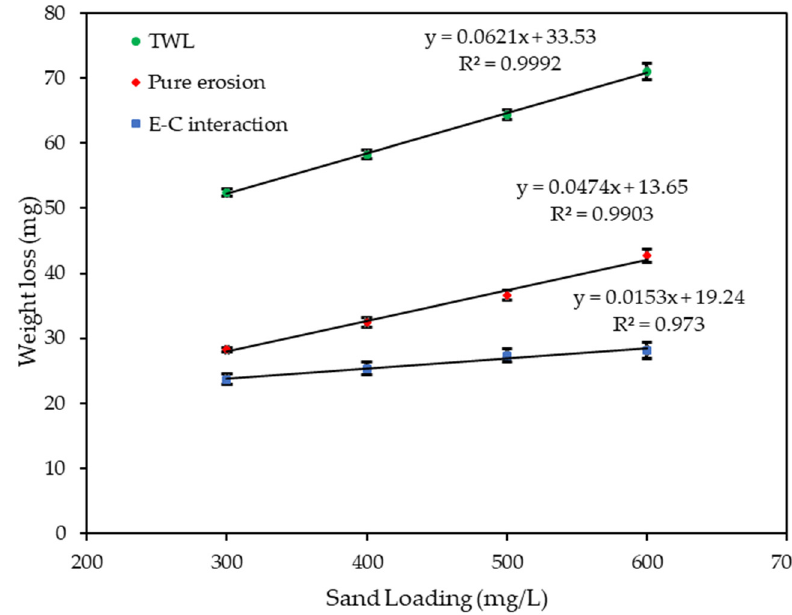
Figure 9. Effect of velocity on weight loss at 600 mg/L.